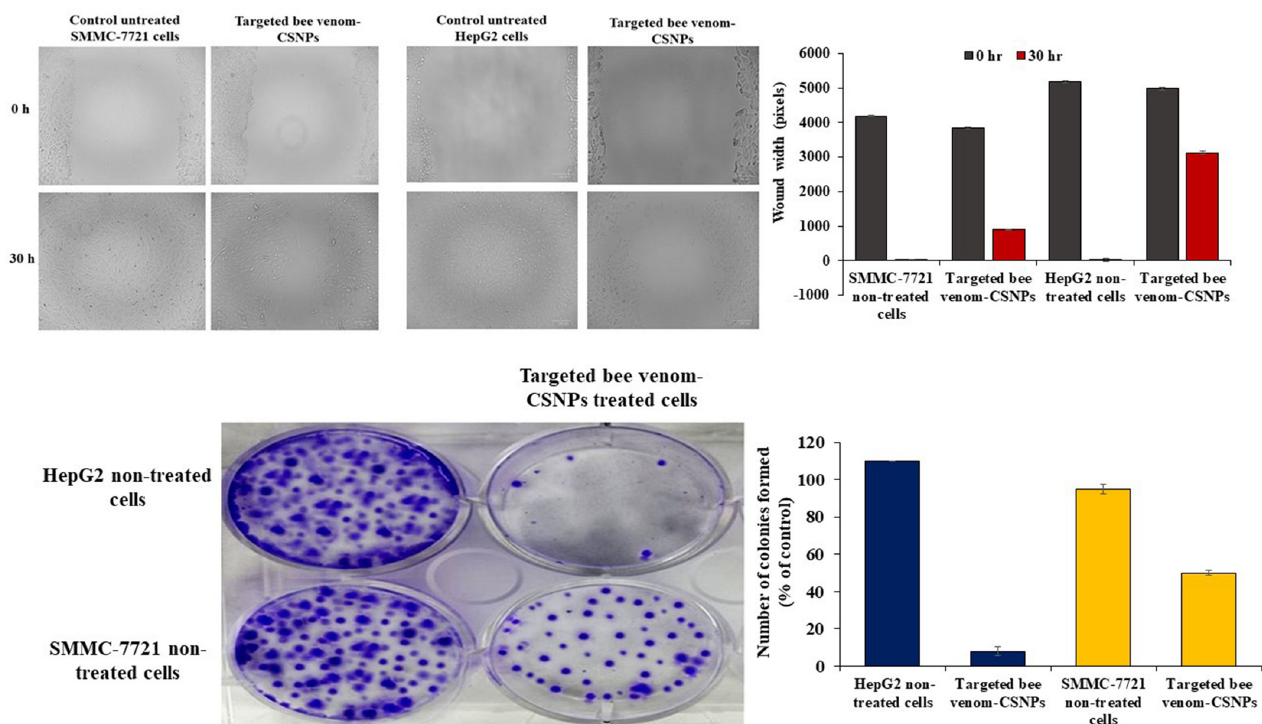
Fig 7. Migration ability of HepG2 and SMMC-7721 cells. ( A ) wound-healing assays; ( B ) colony formation in HepG2 and SMMC-7721 cells treated with targeted bee venom-CSNPs.